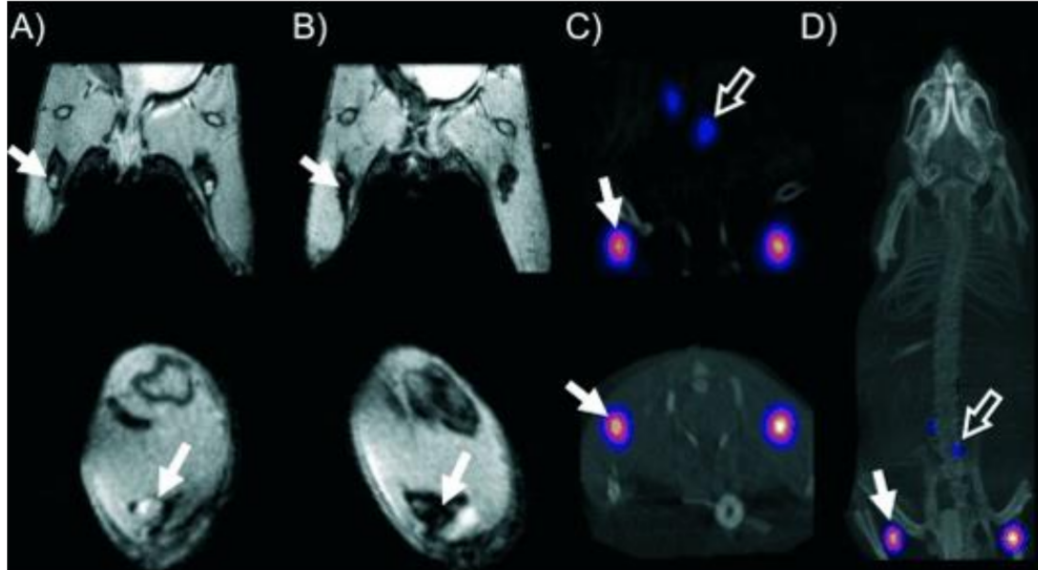
Figure 10. In-vivo dual MRI-PET images obtained from mouse using isotopic-labelled copper dithio- carbamate complex. ( A , B ) Popliteal nodes of coronal ( top ) and short axis ( bottom ) MR images of the lower abdominal area and upper hind legs before ( A ) and after ( B ) injecting dithiocarbamate imaging agents. ( C ) Coronal ( top ) and short-axis ( bottom ) images showing the uptake of the dithiocarbamate ( D ) image of the whole body of the mouse. Reprinted from [176]. Copyright (2011), with permission from Wiley and